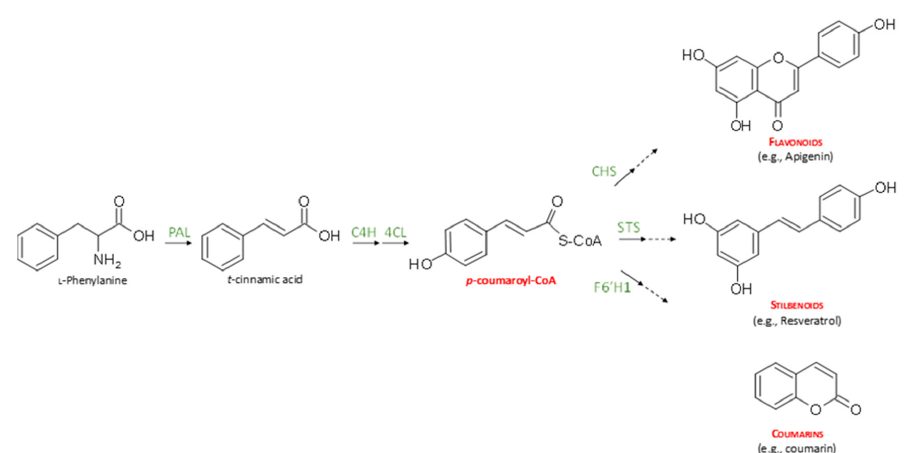
Figure 2. Biosynthetic relationship between the main groups of phenolic compounds (flavonoids, stilbenoids and coumarins) accumulated in various organs of pigeon pea. Their biosynthesis starts with the deamination of l -phenylalanine by l -phenylalanine ammonia lyase (PAL) into trans -cinnamic acid, followed its hydroxylation by cinnamic acid4-hydroxylase (C4H) to form the p -coumaric acid, then the p -coumarate. Coenzyme A ligase (4CL) converts it into p -coumaroyl-CoA, the common precursor of flavonoids, stilbenoids and coumarins. Flavonoids and stilbenoids are formed from the condensation of one molecule of p -coumaroyl-CoA and three molecules of malonyl-CoA but with di ff erent cyclization patterns catalyzed by two distinct enzymes: chalcone synthase (CHS) for the flavonoids vs stilbene synthase (STS) for the stilbenoids. The p -coumaroyl-CoA is also the precursor of coumarin biosynthesis starting with the hydroxylation step at position 6 (cid:48) ( ortho ) catalyzed by feruloyl-CoA ortho -hydroxylase 1 (F6 (cid:48) H1), then followed by the trans > cis isomerization step of the exocyclic double bond, and a lactonization / cyclization